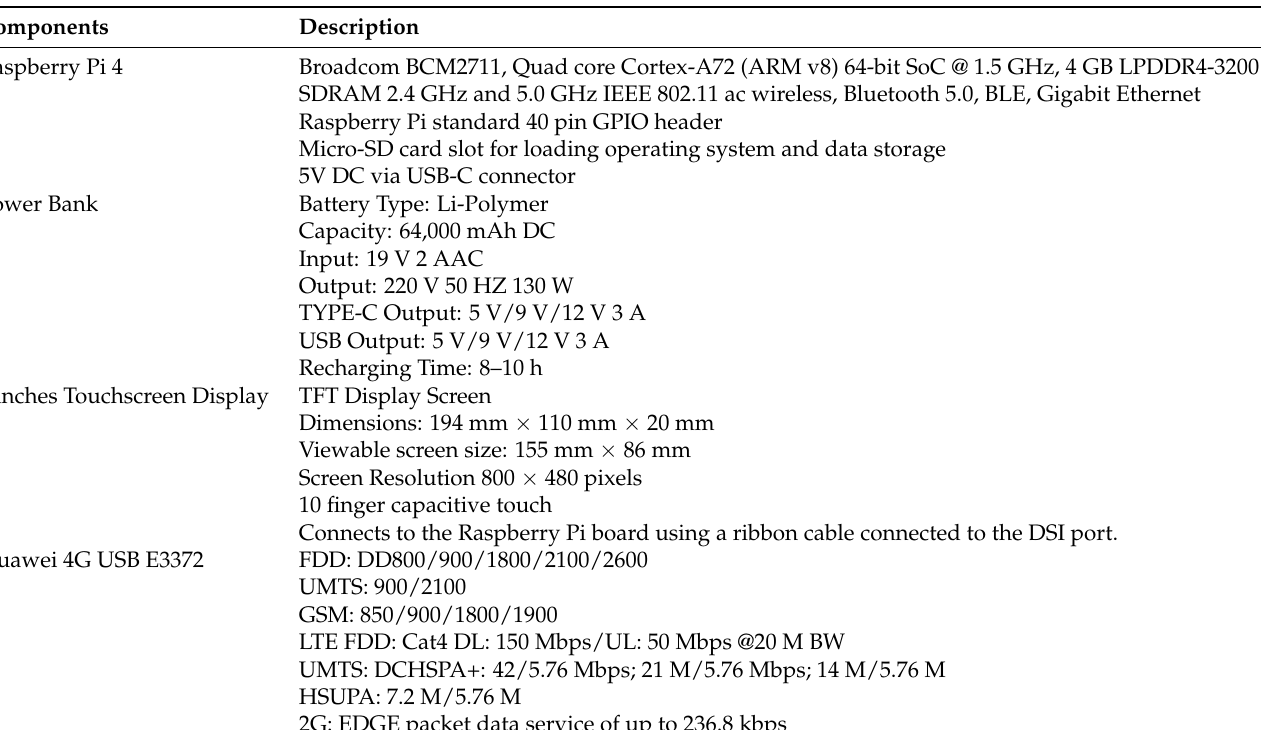
Table 2. Edge device